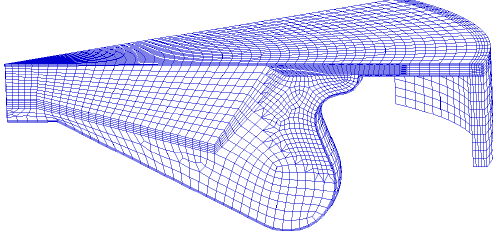
Figure 1. Engine combustion chamber shape and grid diagram.